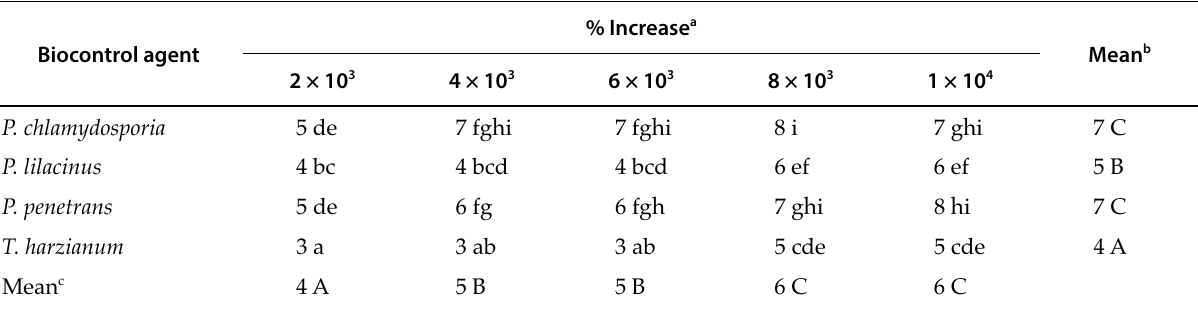
Table 5. Mean proportional increases in root lengths of okra plants after treatments with different nematode biocontrol agents applied at different propagule concentrations.